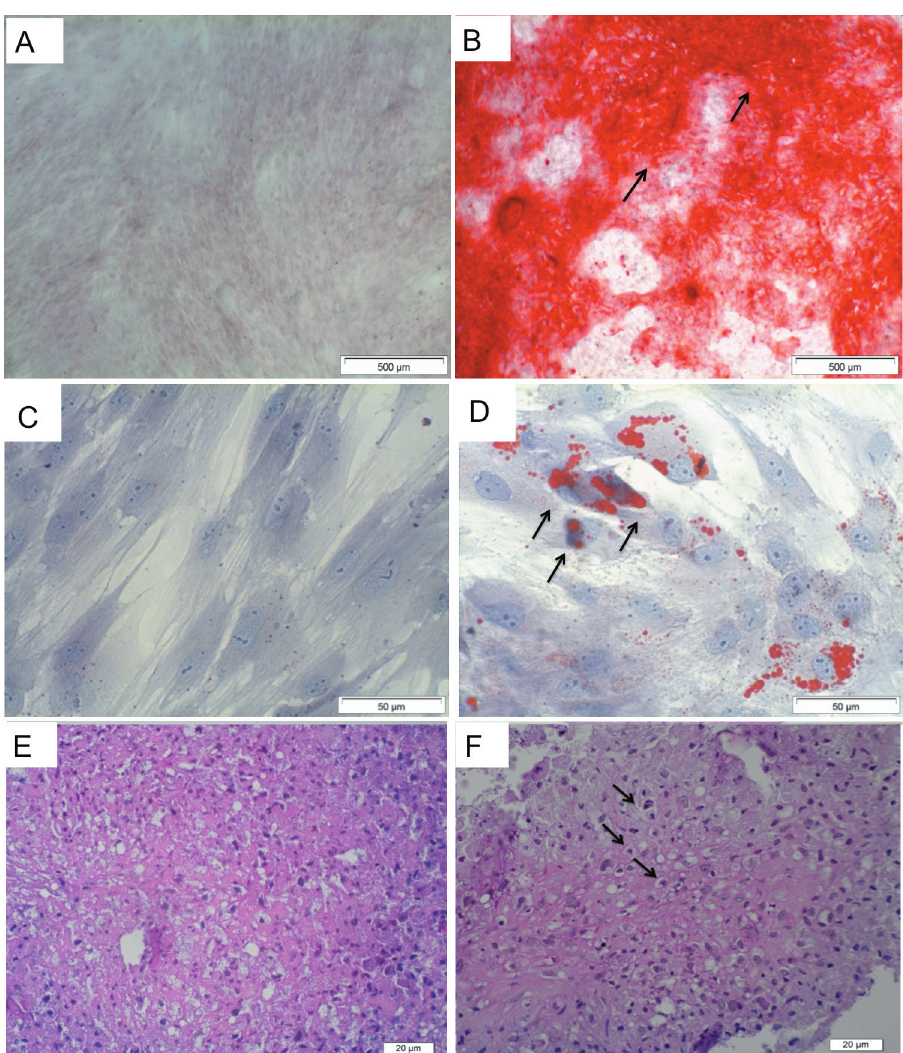
Figure 5- Differentiation of BM-pMSCs into osteoblasts (B), adipocytes (D) and chondrocytes (F) after 21 days of culturing in an induced medium, showing by Alizarin Red S, Oil Red O and Alcian Blue 8GX staining, respectively. Control cells were grown during the same period in a non-induced medium (A, C,